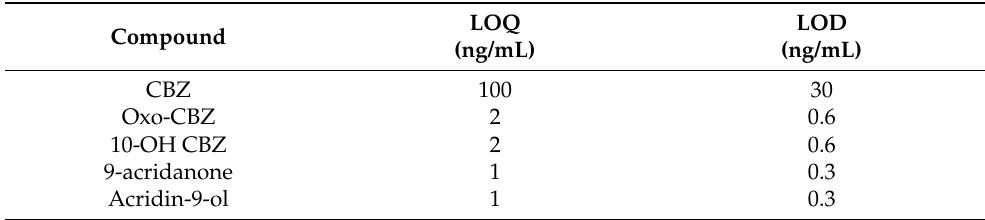
Table 3. Limit of quantification values (LOQ) and limit of detection values (LOD) of CBZ and